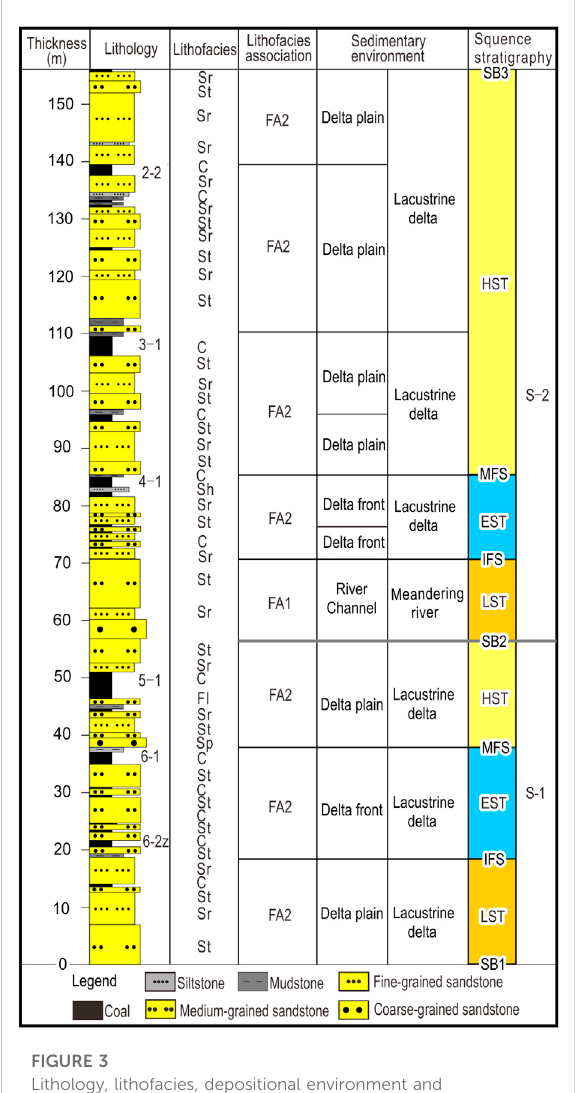
FIGURE 2 Lithology, lithofacies, depositional environment and sequence stratigraphy as determined for borehole 30. See Figure 1B for well location.